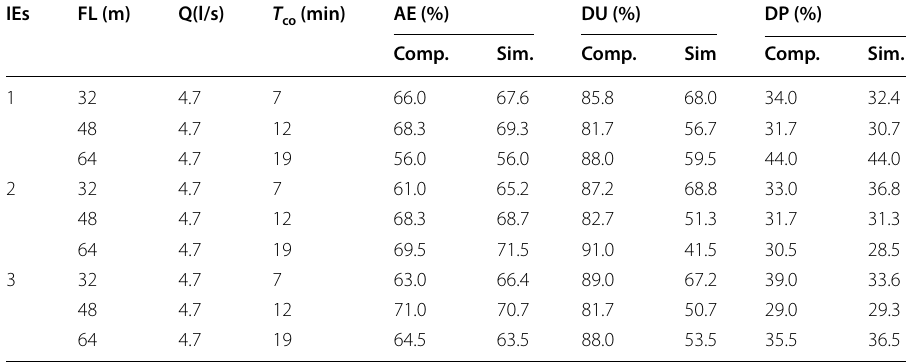
Table 6 Computed and simulated performance indicators by changing cutoff time IEs Comp. Sim. Comp. Sim Comp. Sim.